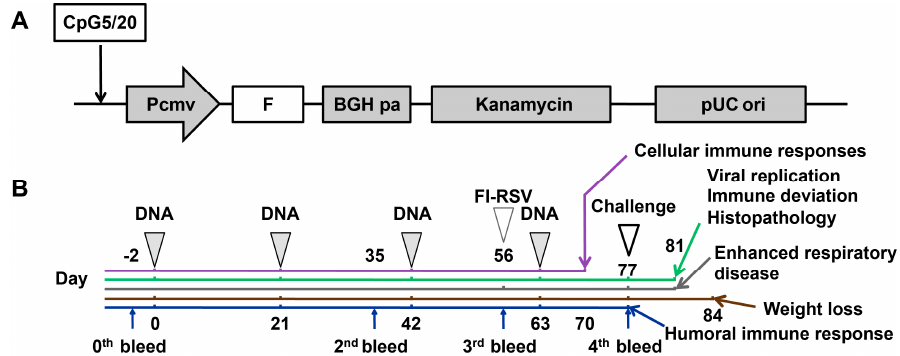
Figure 1. Construction of the modified DNA plasmids with multiple copies of CpG motif, and animal experiment schedule. ( A ) pVAX1 was modified by insertion of five or 20 copies of C-type of CpG ODN in 5